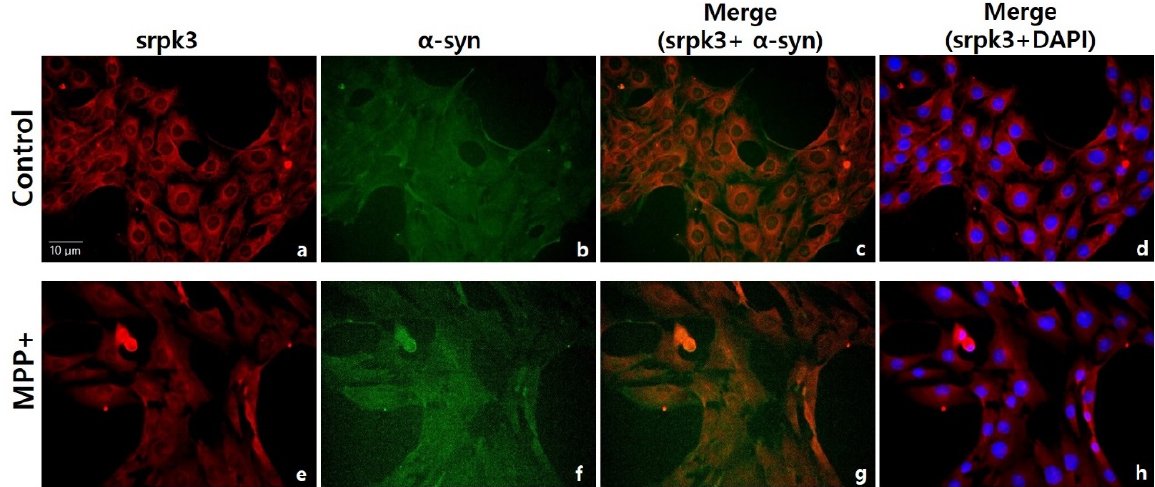
Figure 6. Immunofluorescence staining of serine/arginine-rich protein specific kinase 3 ( srpk3 ) and α -synuclein ( α -syn) in C2C12 cells. Control group: ( a ), srpk3; ( b ) α -syn; ( c ) merging of ( a , b ); and( d ) merging of a and DAPI (nuclei). 1-methyl-4-phenylpyridinium (MPP+) group: ( e ) srpk3; ( f ) α -syn; ( g ) merging of ( e , f ); and ( h ) merging of ( e ) and DAPI (scale bar, 10 µm).